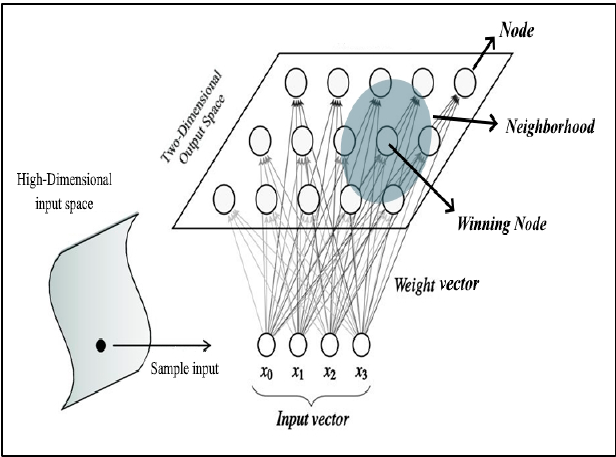
Figure 1. An illustration of a self-organizing map.